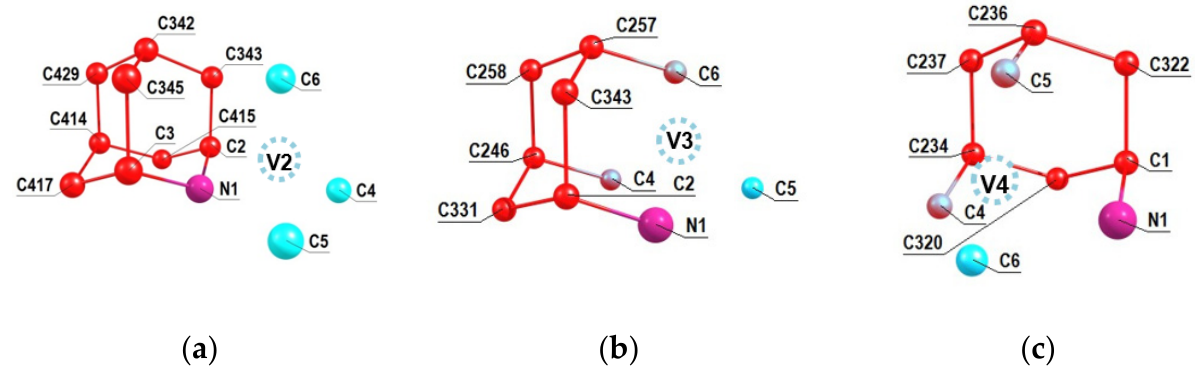
Figure 4. Numeration of carbon atoms in the 2-aza-adamantante seed in the C 510 [NV]-H 252 cluster at the NV2 ( a ), NV3 ( b ) and NV4 ( c ) orientations of the formed NV center with respect to the seed.